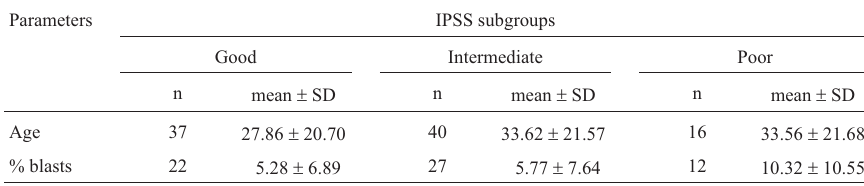
Table 3 - Means of age and % blasts among IPSS subgroups of MDS